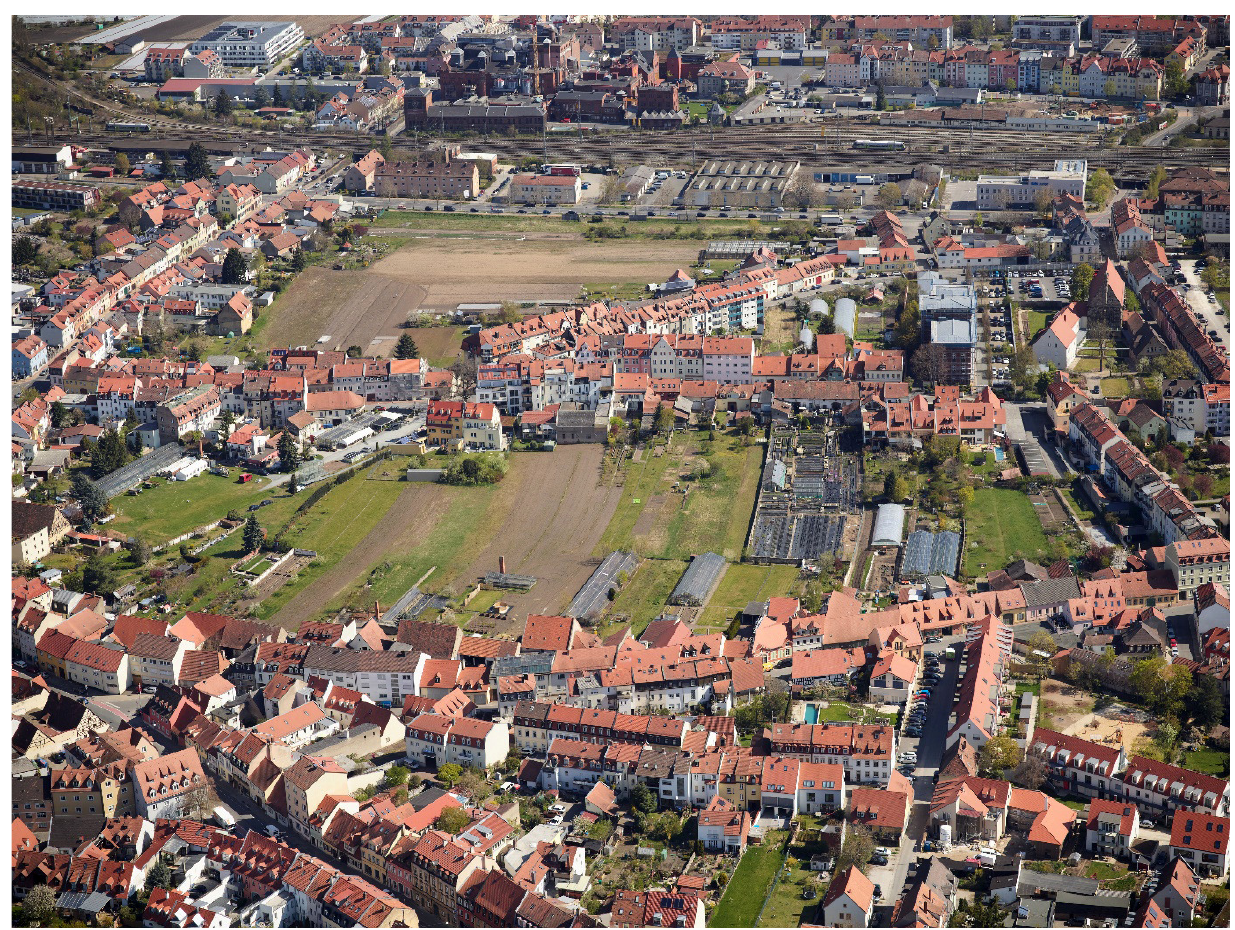
Figure 2. Gärtnerstadt, Untere Gärtnerei, 2021. Source: Schraudner